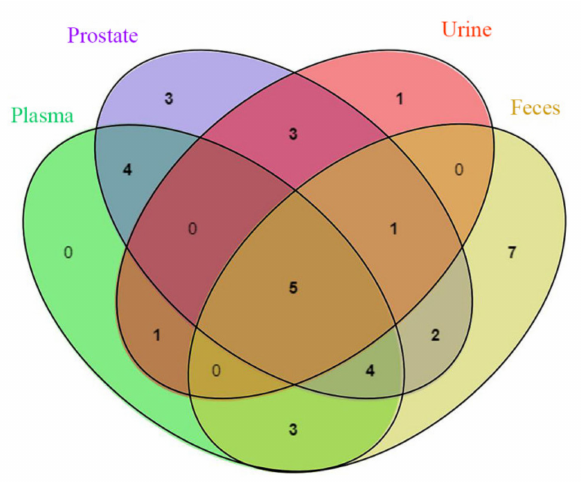
Figure 2. Wayne diagram of the number of prototype components in plasma, prostate, urine and feces. From the perspective of flavonoid glycosides and flavonoid aglycones distribution (Figure 3), there are a large number of flavonoid glycosides in prostate and feces, a large number of flavonoid aglycones in urine, and the same number of flavonoid glycosides and aglycones in plasma.